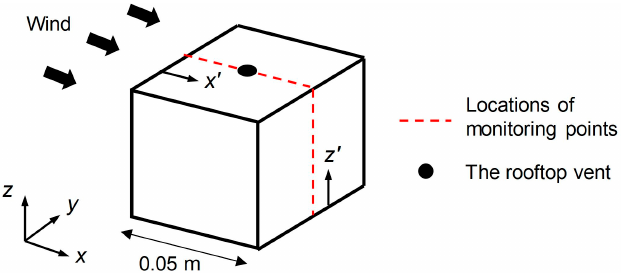
Figure 7. Wind tunnel test performed by Li and Meroney [36].